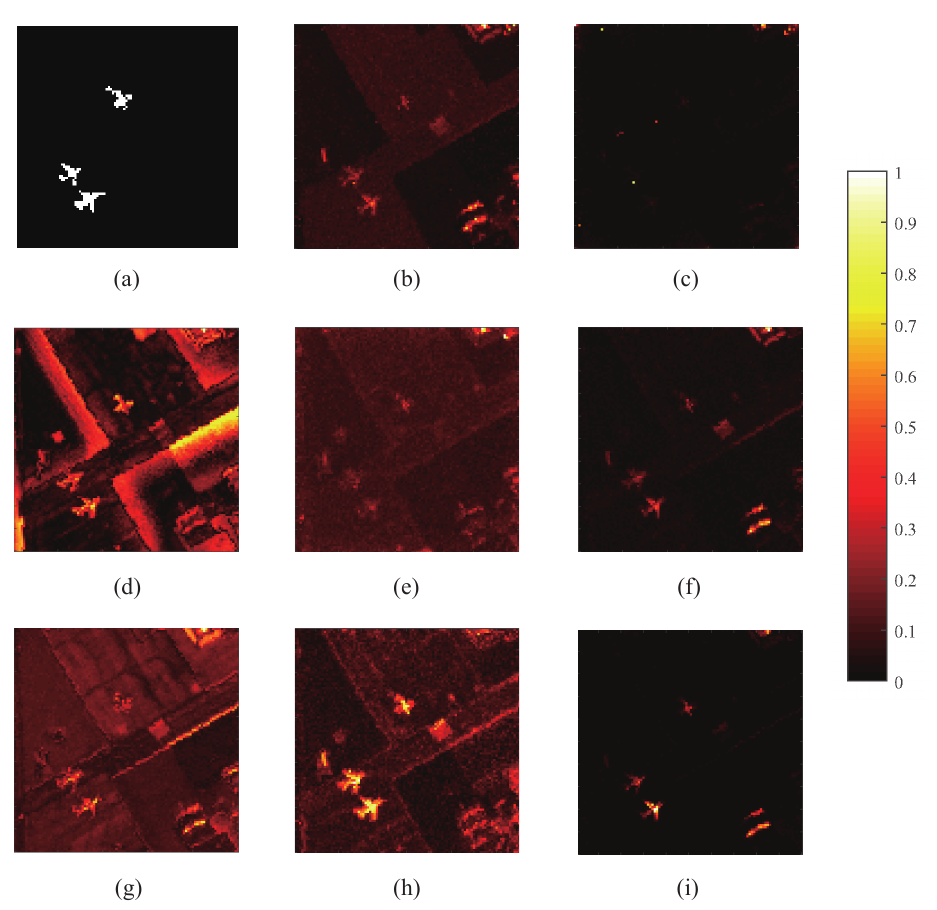
Figure 5. The detection maps of different algorithms for the San Diego airport dataset, the parameters in brackets are sizes of double-window used in corresponding algorithms. ( a ) Reference map. ( b )